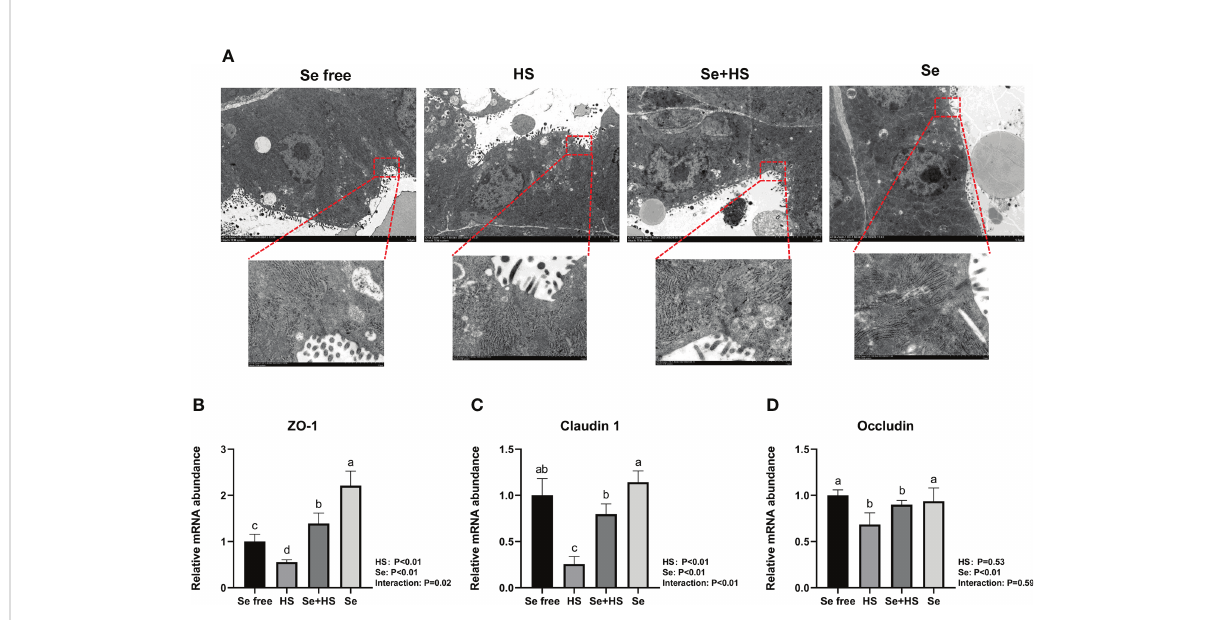
FIGURE 10 Effects of HMSeBA on the tight junction of mammary gland tissues of mice under HS (n = 12). (A) Tight junction structure under transmission electron microscopy. The relative mRNA expression levels of ZO-1 (B) , claudin 1 (C) , and occludin (D) were measured using real-time quantitative PCR. a-c Different lowercase letters indicate extremely signi fi cant differences between two groups ( P < 0.01), while the same lowercase letters indicate no signi fi cant difference between two groups ( P >